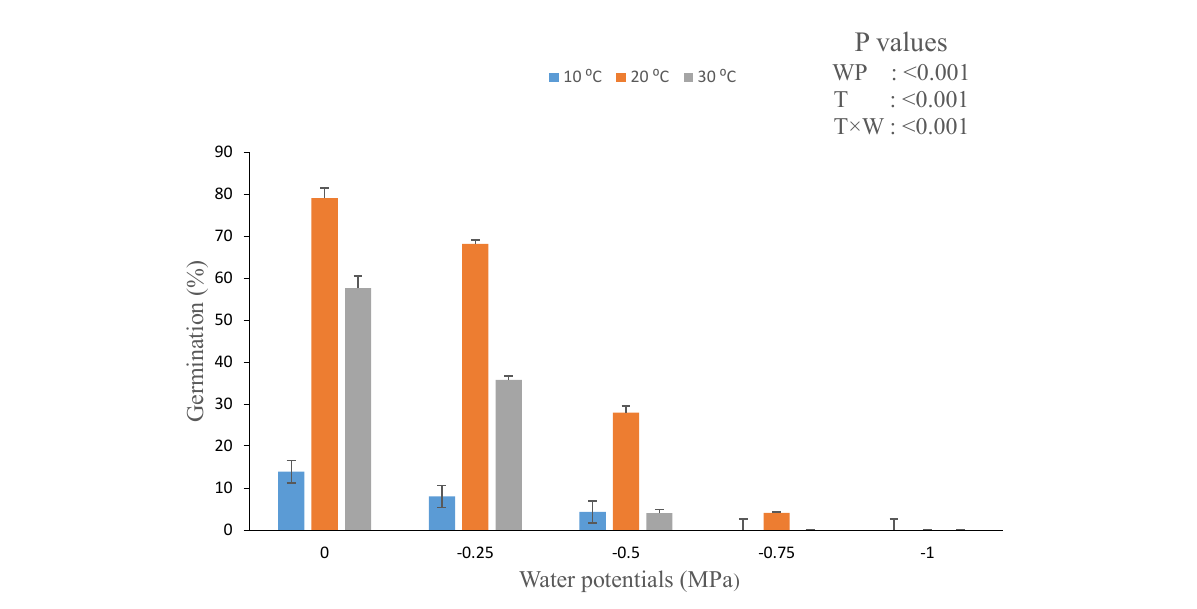
FIGURE3 Interactive effect of water potential and temperature on germination of Parthenium hysterophorus seed under controlled conditions. Values are means ± standard error.